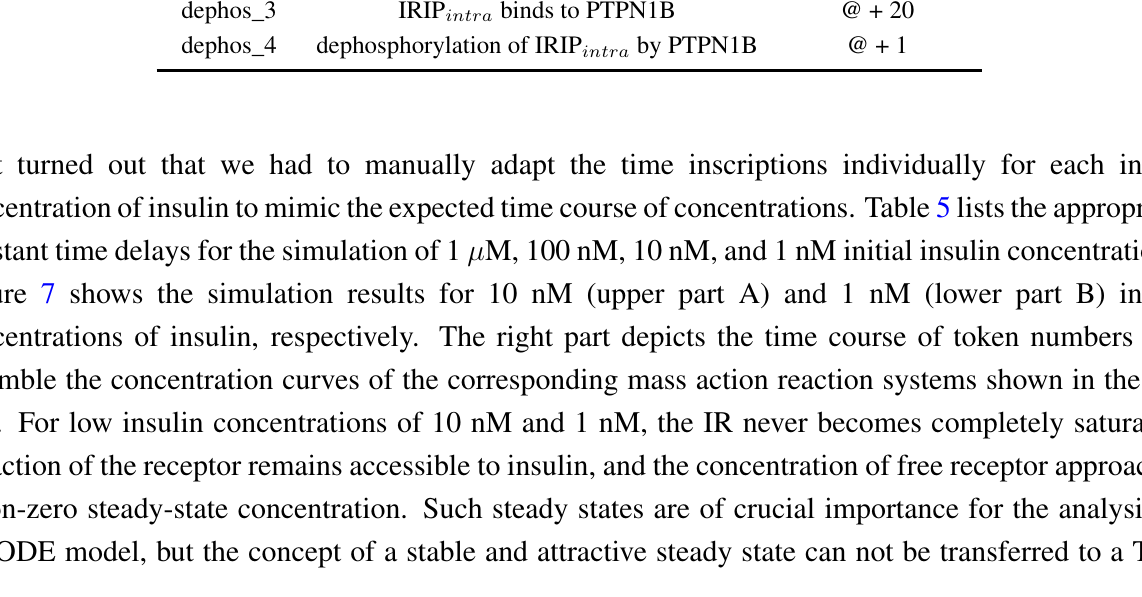
Table 4. List of transitions of the TPN model of receptor phosphorylation and recycling. The time inscriptions of the transitions are constant delay increments. We adapted the values of the constant delays to each initial insulin concentration of 1 µ M, 100 nM, 10 nM, and 10 nM separately. This list exemplifies the constant delays for i